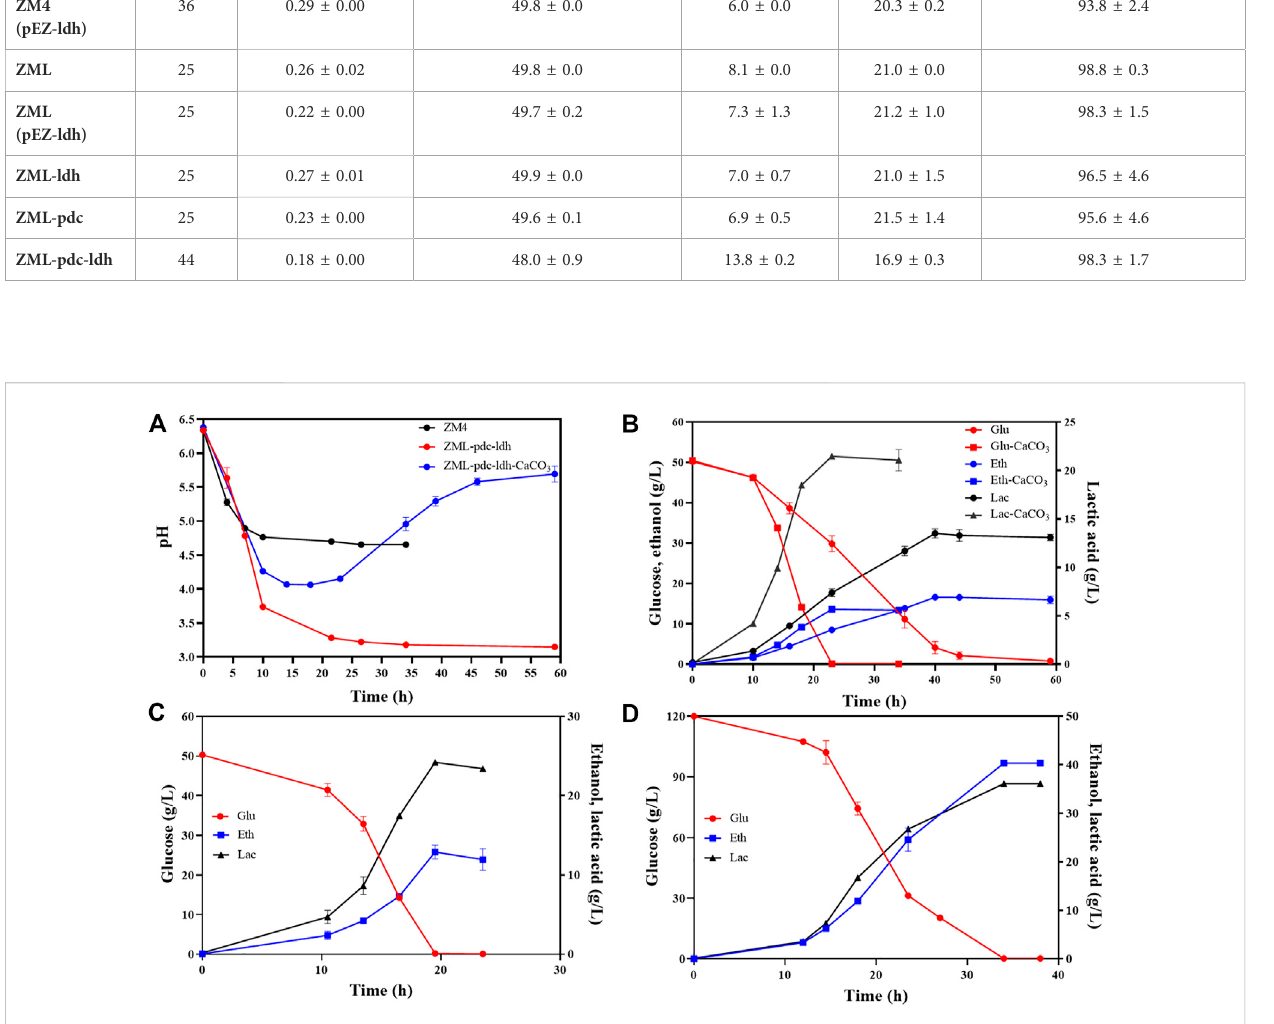
FIGURE 2 pH changes of wild-type ZM4 and the recombinant strain ZML-pdc-ldh during fermentation (A) , and glucose consumption, lactate and ethanol productionofZML-pdc-ldh (B) inthepresenceorabsenceofCaCO 3 ,aswellasglucoseconsumption,lactateandethanolproductionofZML-pdc-ldhin RMG5 (C) or RMG12 (D) in pH-controlled fermenters. Glu, Eth and Lac represent glucose, ethanol, and lactate, respectively. Three replicates were performed for the